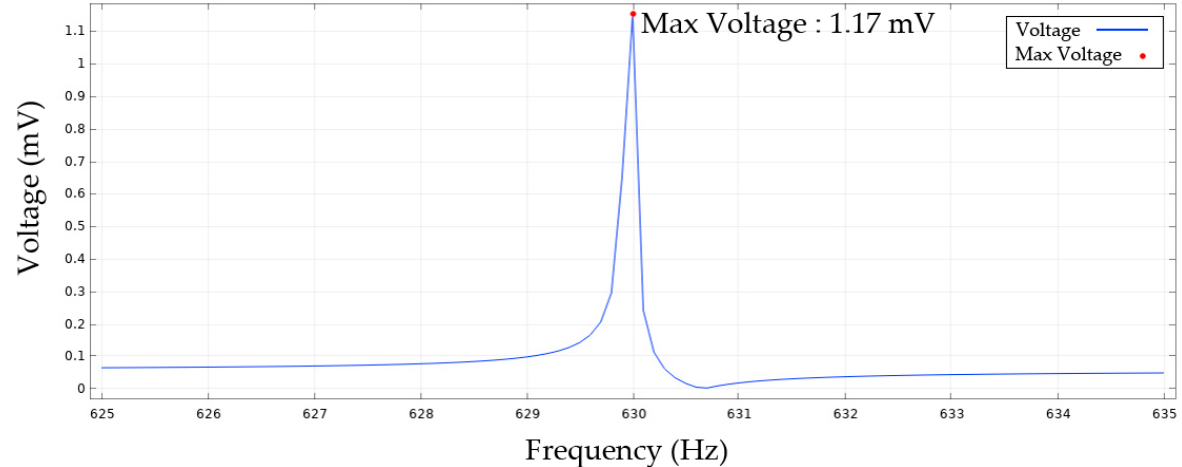
Figure 13. Output voltage from piezoelectric beam I at first mode shape.